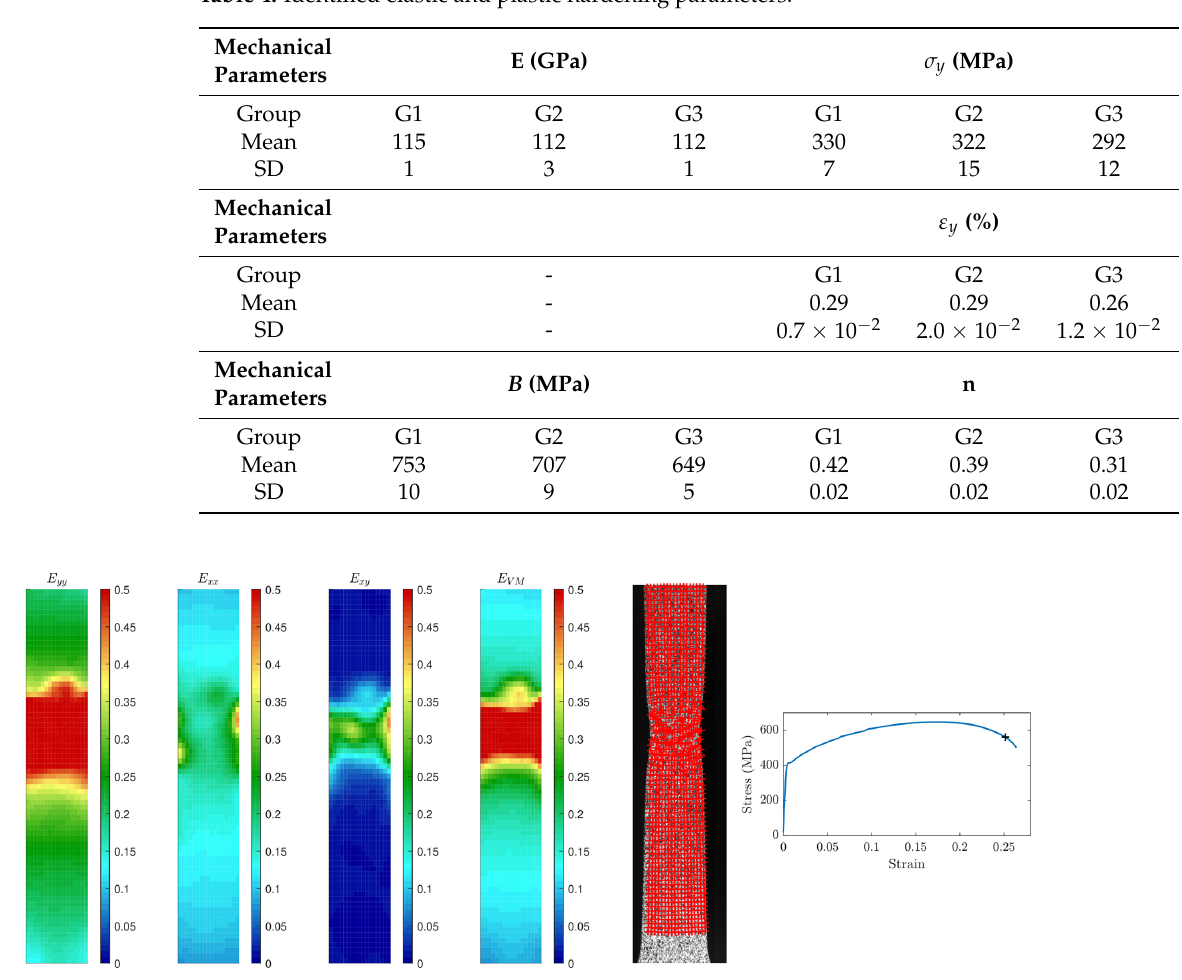
Table 4. Identified elastic and plastic hardening parameters.